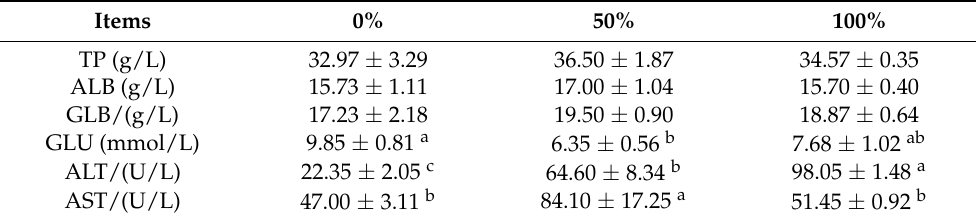
Table 4. Effects of common reed on serum biochemical parameters of grass carp (N =